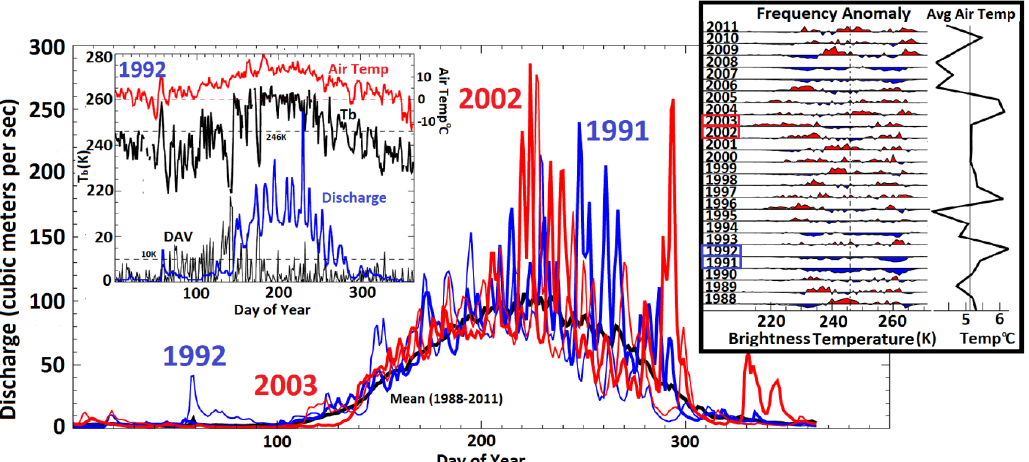
Figure 9. Discharge for the Mendenhall River near Auke Bay, AK (USGS 15052500, see Figure 3 for location) for two negative T anomaly years in blue (1991 and 1992) and two b positive T anomaly years in red (2002 and 2003) compared to the mean 1988 to 2011 b (thick black line).